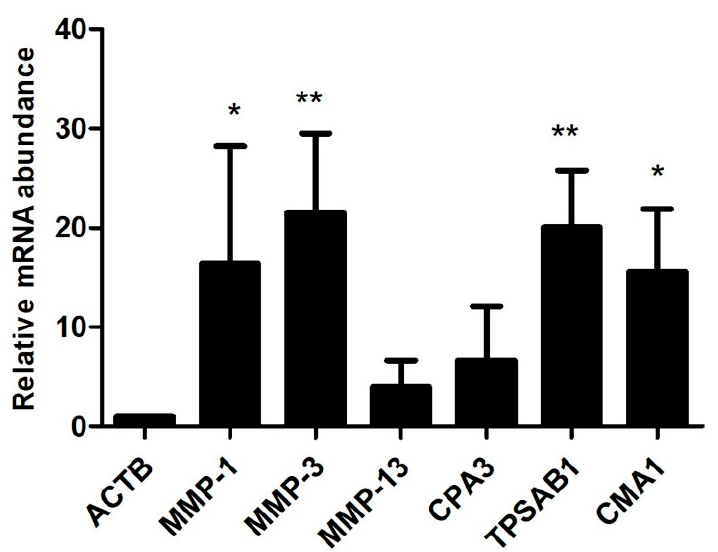
Figure 3. qRT-PCR analysis to validate transcriptome results of the osteophyte samples. mRNA levels of CPA3, CMA1, TPSAB1, MMP-1, MMP-3 and MMP-13 were normalized against ACTB, the housekeeping gene. All the values are expressed as mean ± SD. TPSAB1 (20.04-fold), CMA1 (15.57-fold), MMP-1 (16.32-fold) and MMP-3 (21.5-fold) showed a significant up-regulation. CPA3 (6.64-fold) and MMP-13 (4.01-fold) also showed up-regulation, which remained insignificant on statistical scale, however. This qRT-PCR validation is limited to confirm the expression of key upregulated genes from the transcriptomics data in the osteophytes. * p < 0.05, ** p < 0.01 compared to